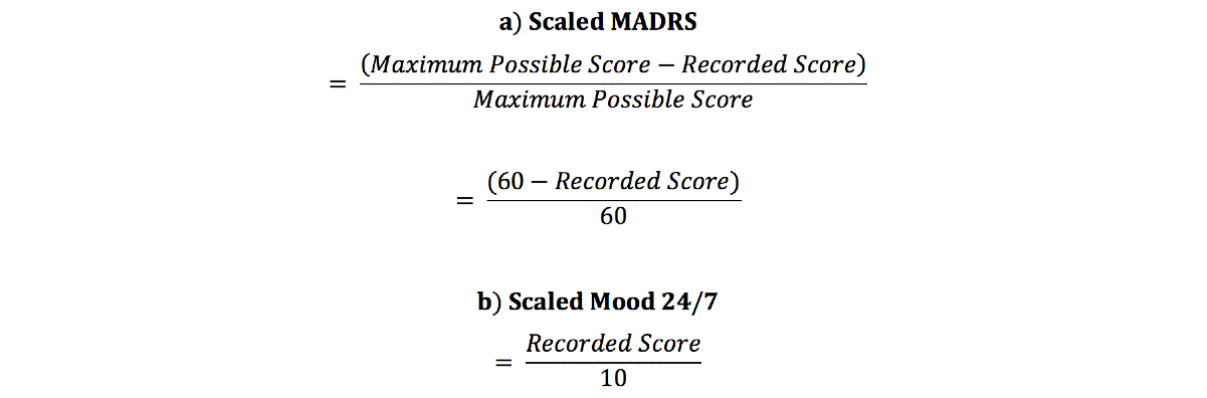
Figure 1. Montgomery-Åsberg Depression Rating Scale (MADRS) (a) and Mood 24/7 (b) scores were converted to a common scale (0 to 1). Note that MADRS scaling was also inverted such that improvements in mood were represented as greater values.